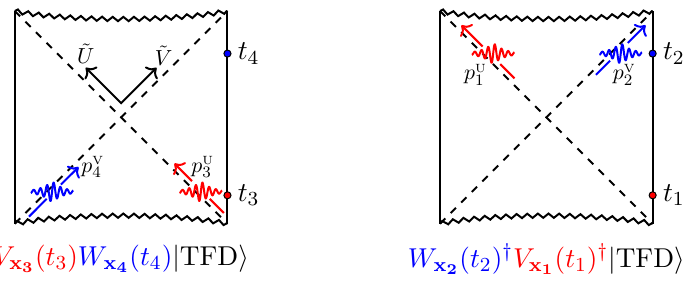
( t 3 ) W x ( t 4 ) j TFD i on a bulk slice that touches 3 4 ( t 2 ) y W x ( t 1 ) y j TFD i on 2 1